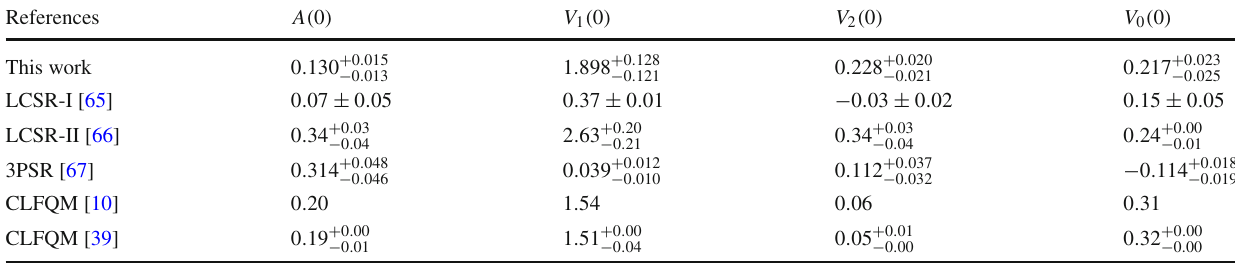
Table 3 The D → a 1 ( 1260 ) TFFs at the large recoil region, i.e. A ( 0 ), V 1 ( 0 ), V 2 ( 0 ), V 0 ( 0 ) . Predictions under various approaches are also